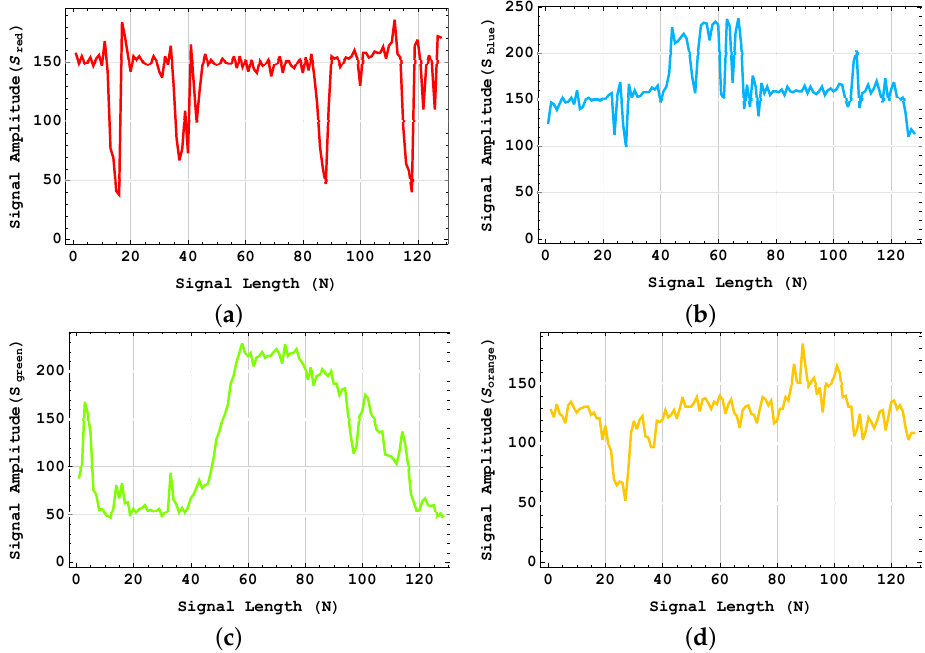
Figure 9. The plots of four test signals extracted from the “Boat” image: ( a ) row 100, ( b ) row 256, ( c ) row 310, and ( d ) row